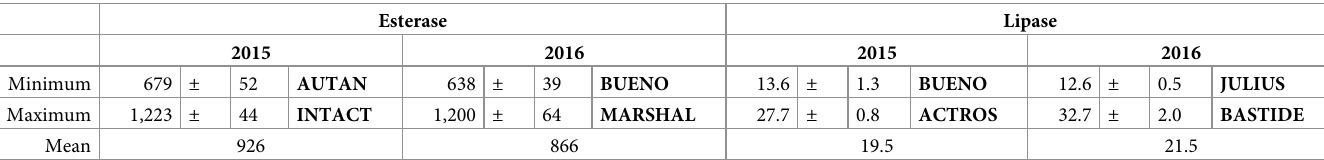
Table 1. The minimum, maximum, and mean values of esterase and lipase activities measured in 300 wheat cultivars grown in 2015 and 2016. Unit: